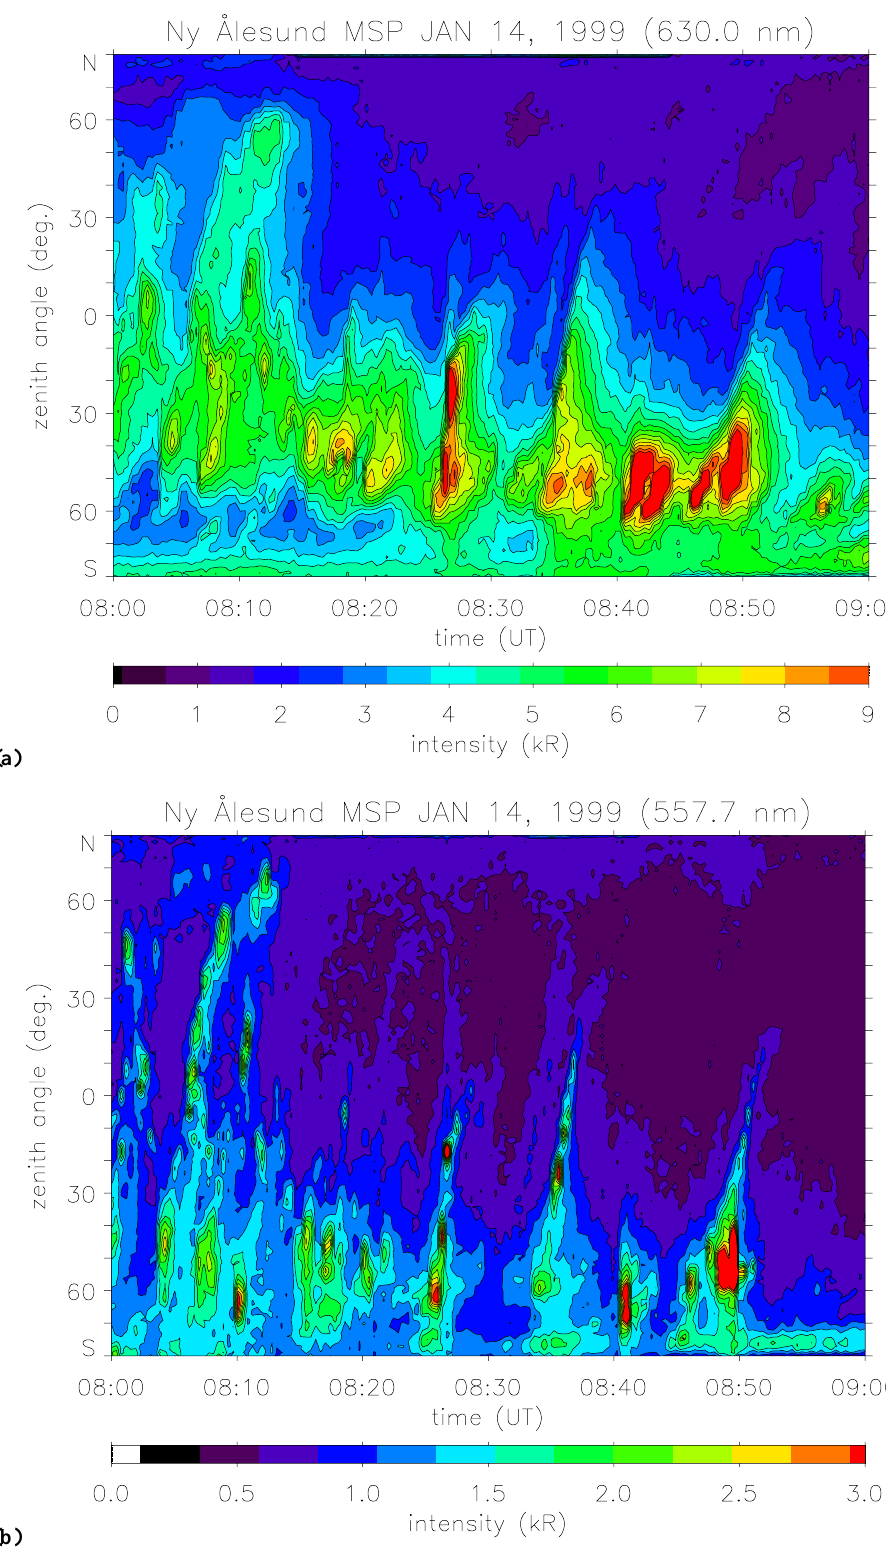
Fig. 3. Meridian scanning photometer line of sight intensities versus zenith angle, at 630.0nm (a) and 557.7nm (b) , for the interval 08:00– 09:00UT on 14 January 1999. Intensities are colour-coded according to the scale at the